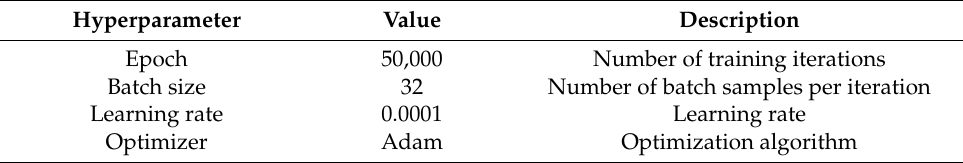
Table 6. Hyperparameter configuration of the proposed GAN model. Hyperparameter Value Description Epoch 50,000 Number of training iterations Batch size 32 Number of batch samples per iteration Learning rate 0.0001 Optimizer Adam Optimization